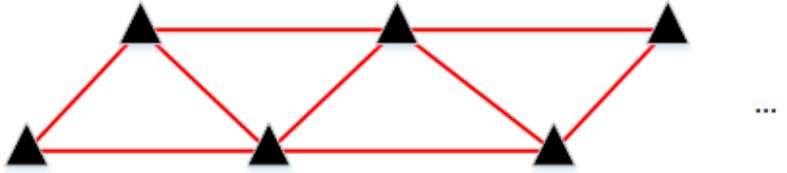
Figure 8. Two-connection network mode. The black triangles represent the SAR images in chronological order from left to right, and the red lines represent different interference pairs.